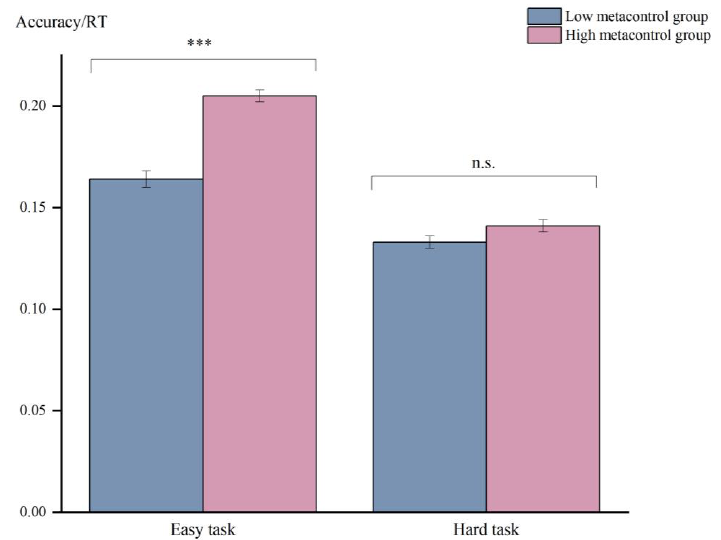
Figure 3. Performance ratio (accuracy divided by hit RT) of the low- and high-metacontrol groups for the easy and hard tasks. Error bars represent standard errors (*** p < 0.001, n.s., shows no significant difference).